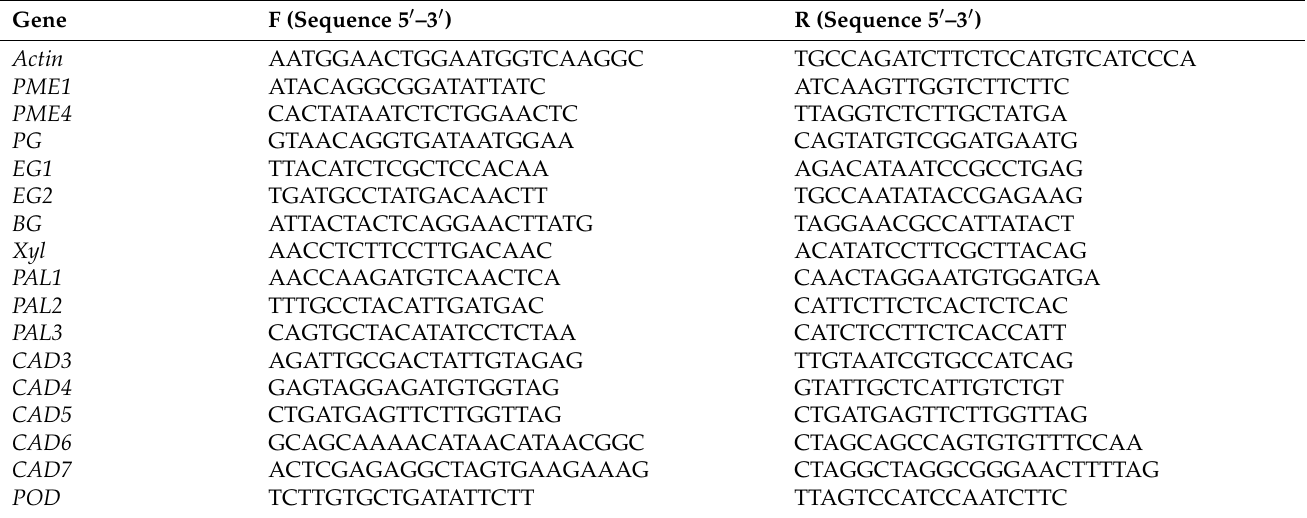
Table 1. Primers used for quantitative real-time polymerase chain reaction in this